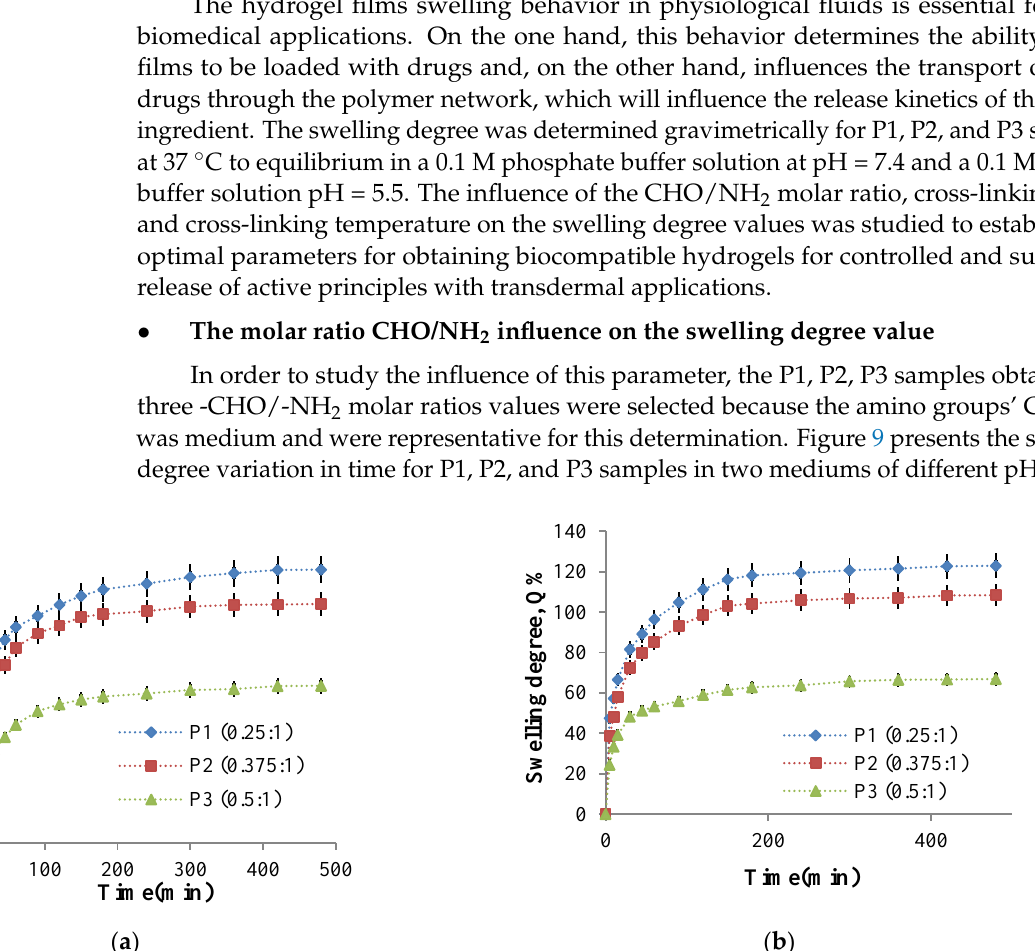
Figure 9. The variation in time of the swelling degree for P1, P2, and P3 samples using different molar ratios in two solutions of different pH: ( a ) pH = 5.5 and ( b ) pH = 7.4.